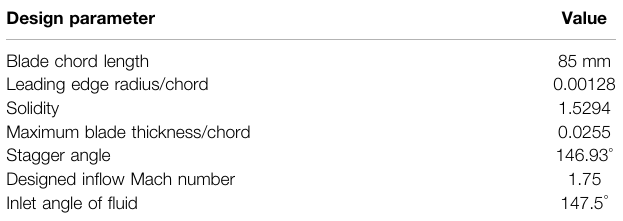
TABLE 1 | Main parameters of the compressor cascade.